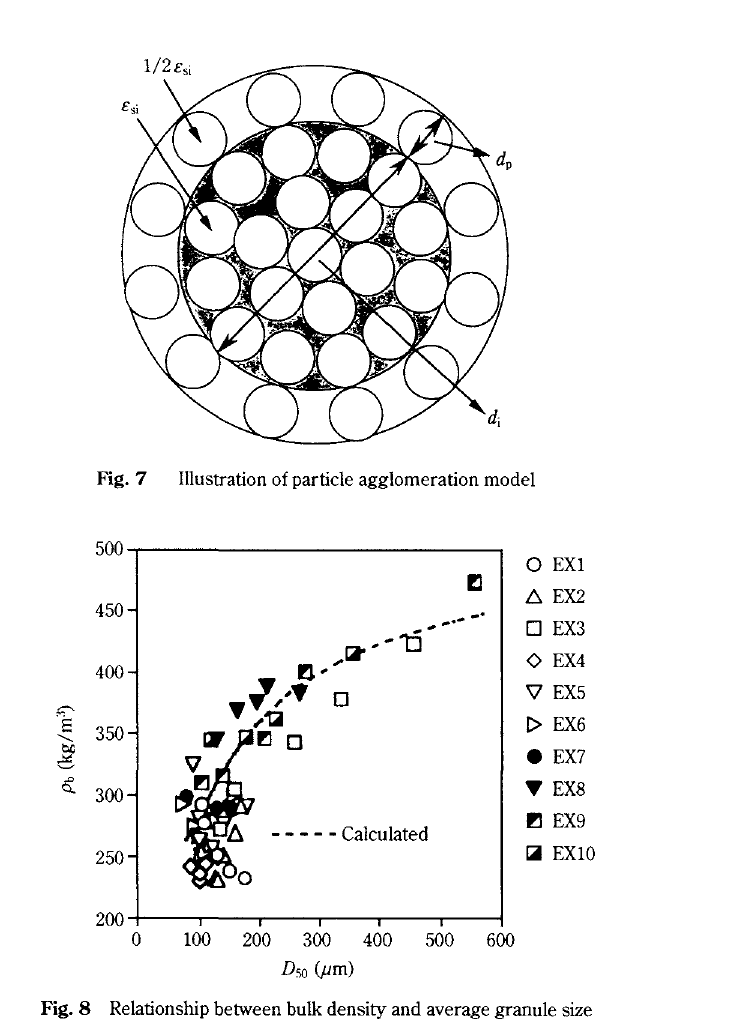
Fig. 8 Relationship between bulk density and average granule